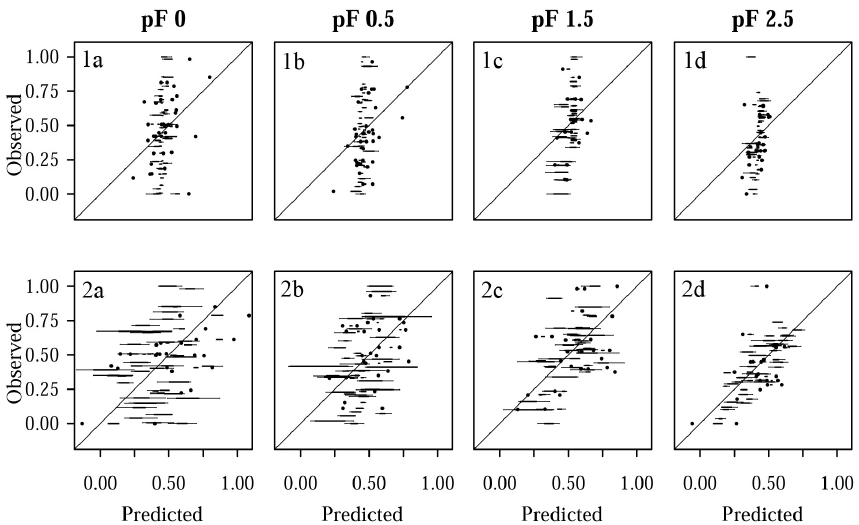
Figure 9. Comparison of predicted and observed water retention values for Laipuna, showing (1a–d) models with tuning by grid search and (2a–d) models with parameter tuning by differential evolution for (1a, 2a) pF 0, (1b, 2b) pF 0.5, (1c, 2c) pF 1.5, and (1d, 2d) pF 2.5. Each boxplot is based on five values resulting from five CV repetitions. Predicted and observed values were scaled to the range [0, 1]. Table 2. Unscaled root-mean-squared errors for the tested PTFs. The best results for each matric potential are shown in bold. BRT PTF results are